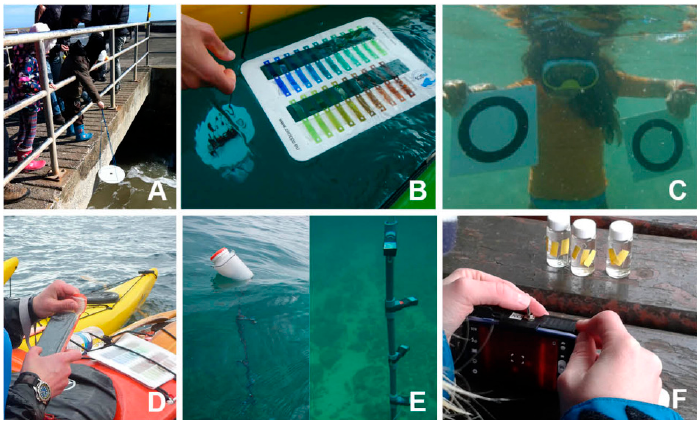
Figure 1. Citclops-tools for different user groups as used during public training events. Data collection with ( A ) Secchi disk in Ireland (A. Friedrichs); ( B ) Forel-Ule plastic scale in Spain (J. Piera); ( C ) TrandiCam plates in Spain (C. Simon); ( D ) Data collection by means of EyeOnWater-Colour app in Spain (J. Piera); ( E ) Data collection for technically experienced users with KdUINO in Spain (J. Piera); and ( F ) SmartFluo in Ireland (J. Busch).